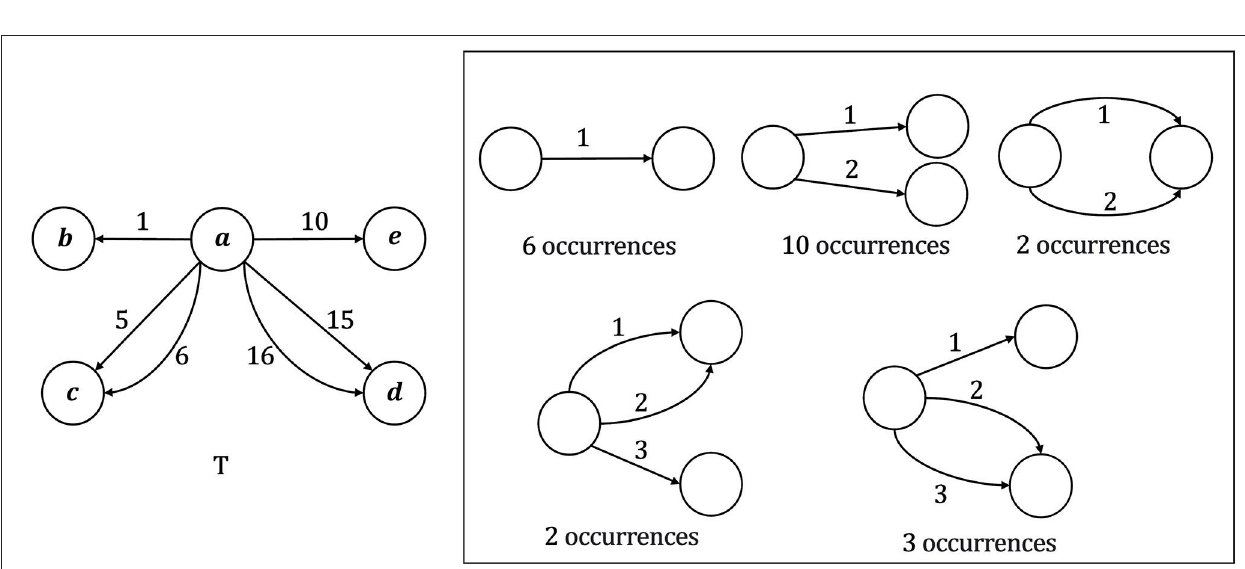
FIGURE 2 | Example of application of the Temporal Motif Search (TMS) problem for a temporal graph T , given 1 = 10, k = 3, and l = 3. For each motif, the relative number of 1 -occurrences in T is reported.